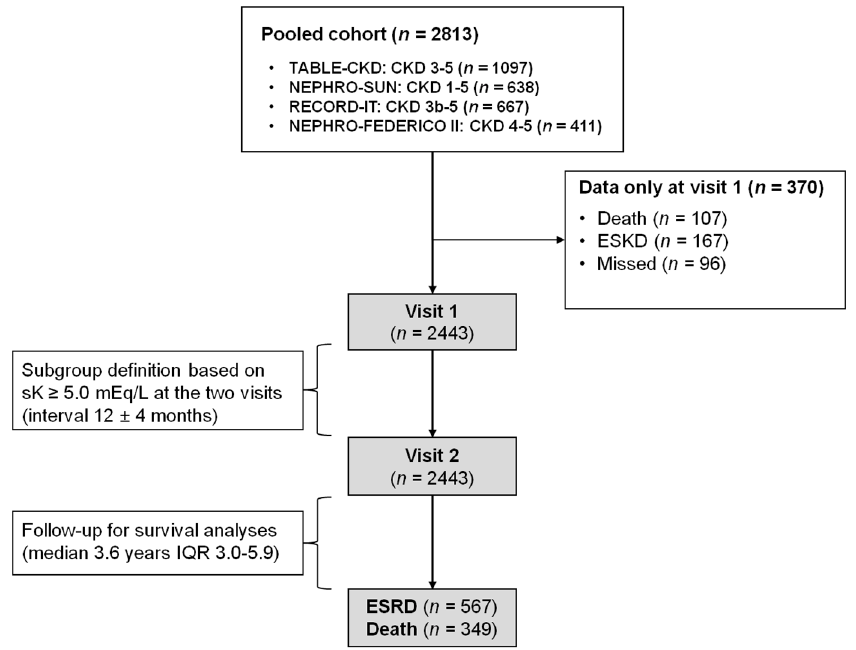
Figure 1. Study flow chart.